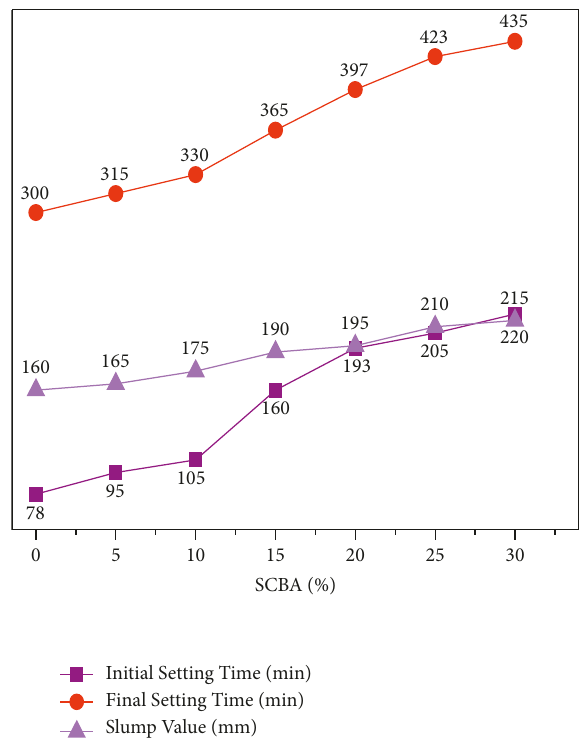
Figure 16: Slum value, initial setting time, and final setting time of fresh concrete [79].